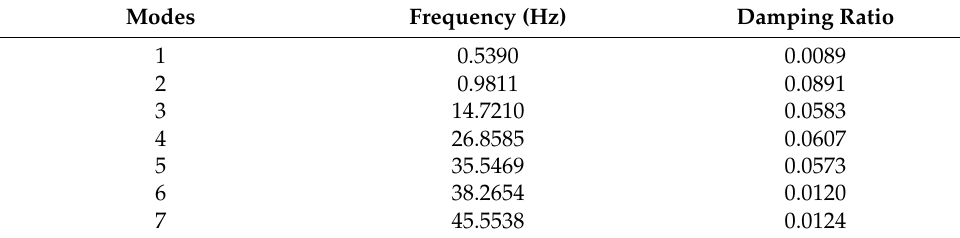
Table 10. Modal parameters of real-time signal identified with SSI approach.